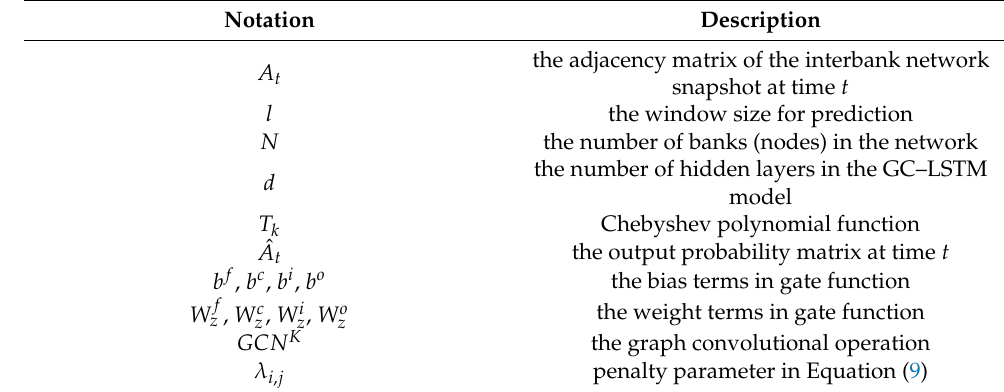
Figure 2. Architecture of Long short-term memory model. The notations of the graph are shown as follows. f t , i t , o t are the forget gate, input gate and output gate. C t is the cell state, ˜ C t is the new candidate values, x t is the input at time t and h t is the hidden state. × is the pointwise multiplication operation, + is the addition operation, σ is the sigmoid function and tanh is the hyperbolic tangent function. Table 1. Notations used in the GC–LSTM